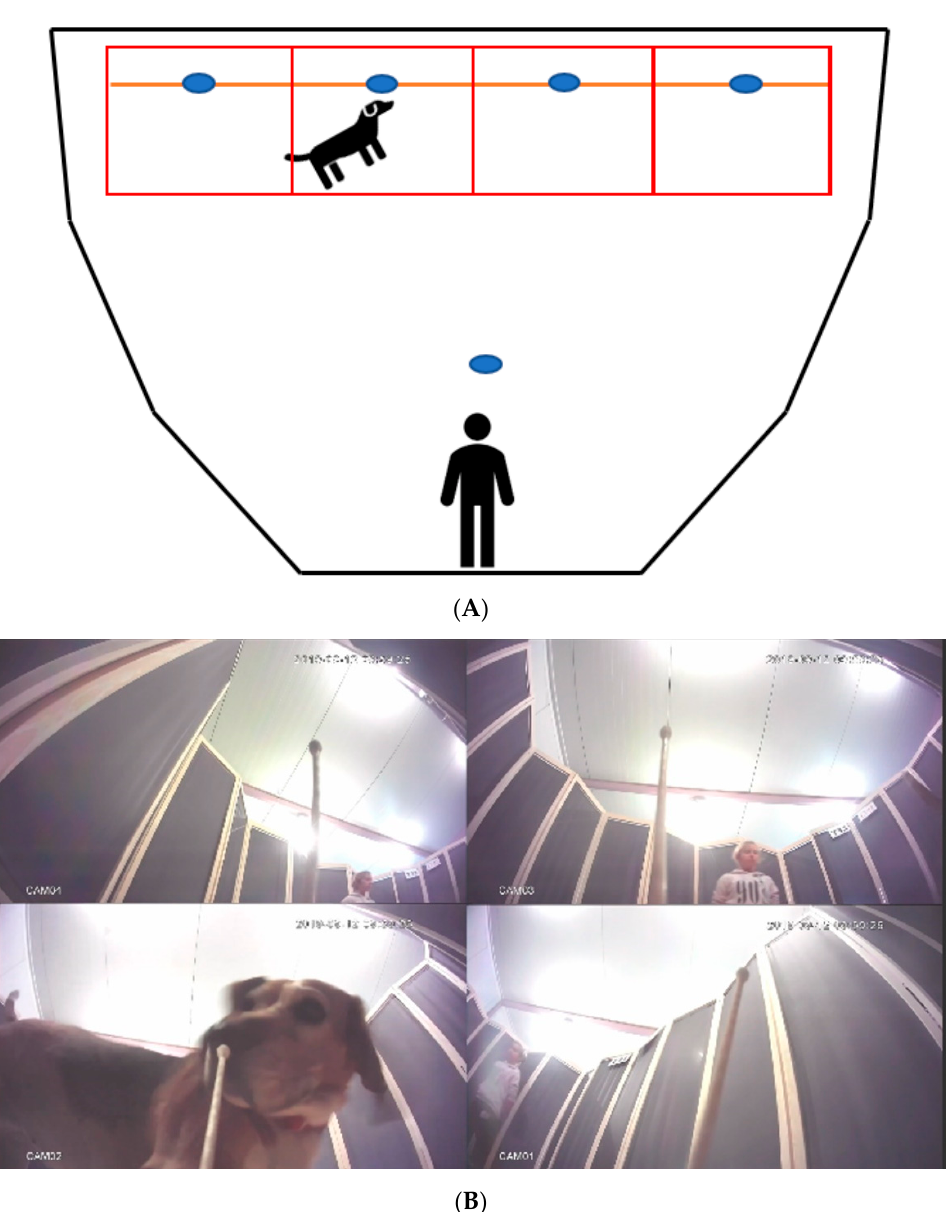
Figure 1. ( A ) Arrangement of the experimental area. The blue dots show the camera positions. The red squares represent zones. ( B ) The view from sample cameras.